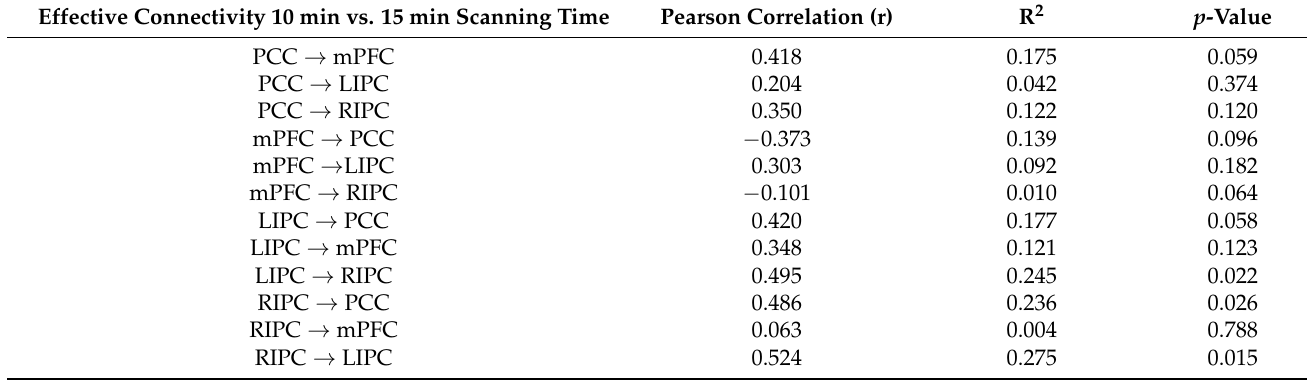
Table 3. Value of Pearson correlation (r), R 2 , and p -value between 10 min vs. 15 min scanning